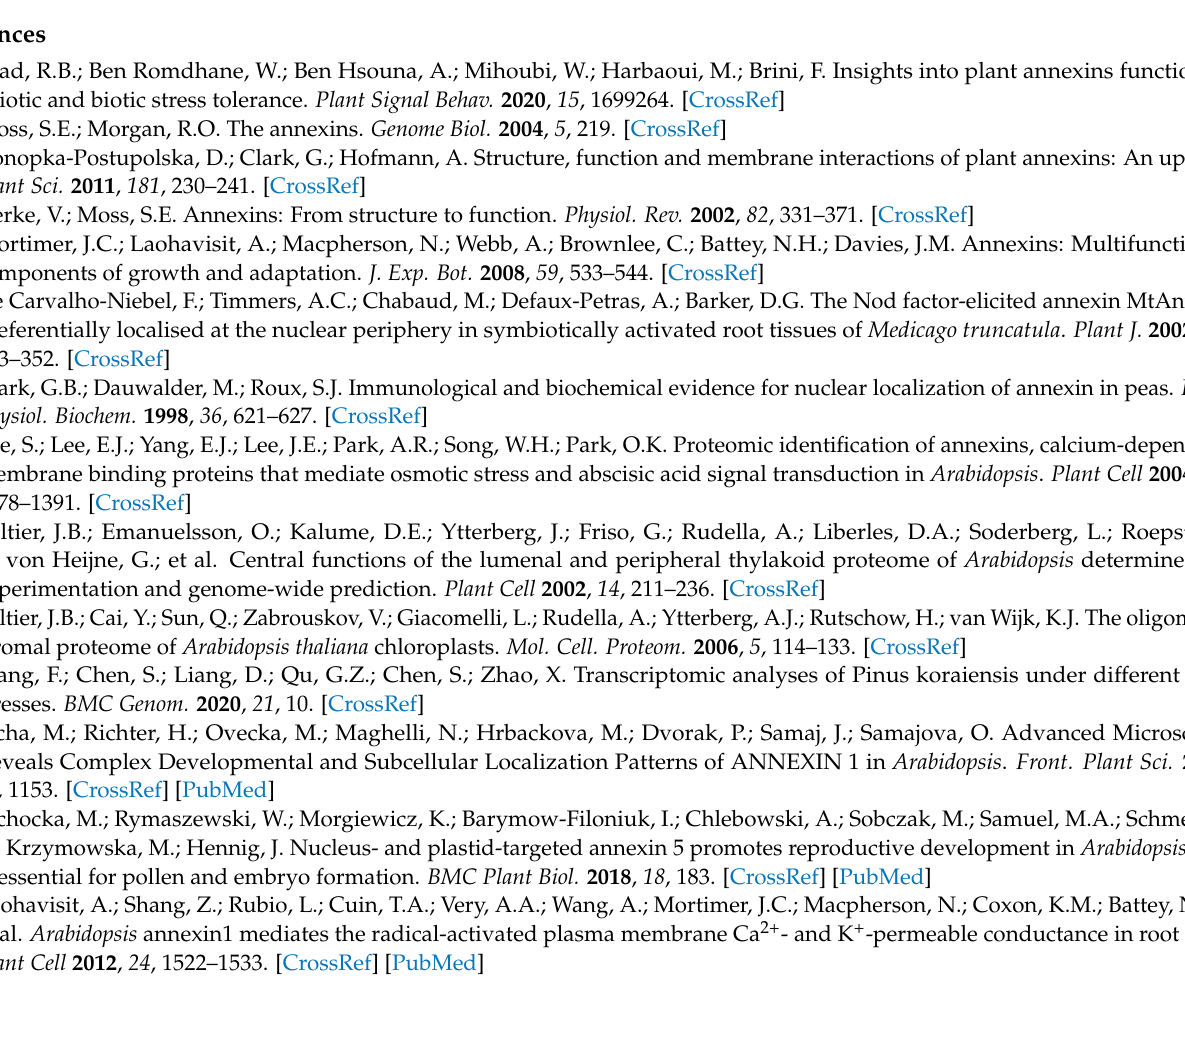
Figure S1. Cloning and sequence analysis of MeAnn2 cDNA from SC8 cassava. Figure S2.